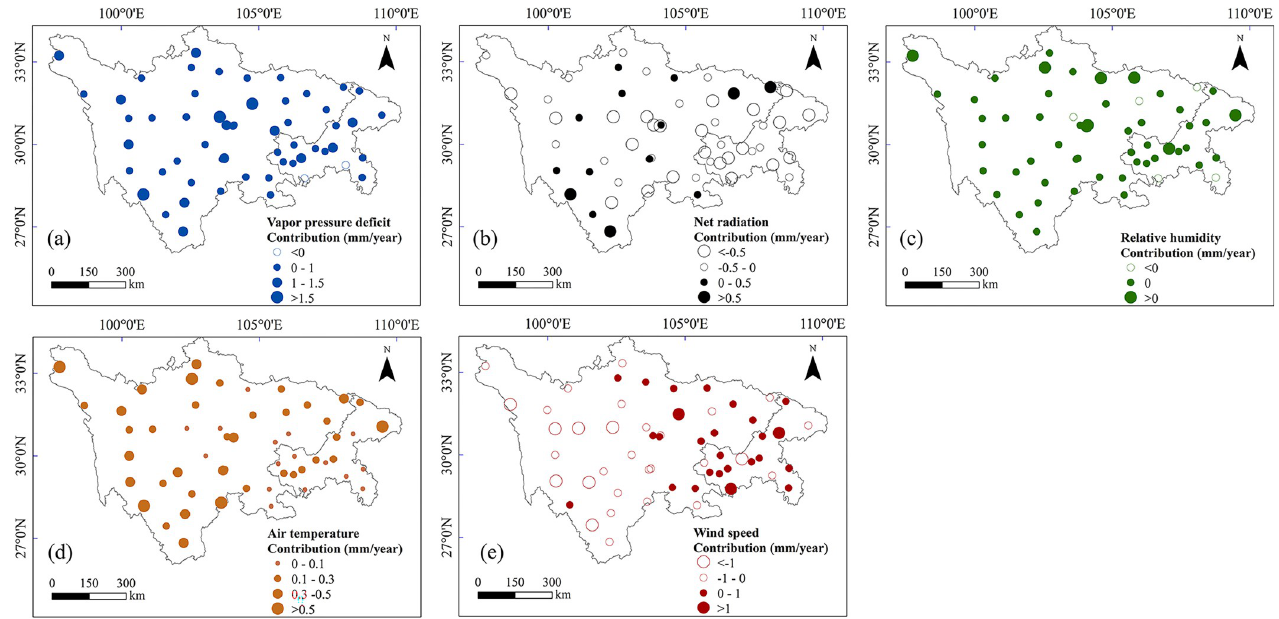
Fig 8. Spatial distributions of contributions of five basic meteorological factors ((a) vapor pressure deficit, (b) net radiation, (c) relative humidity, (d) air temperature, and (e) wind speed) to PET trends at an annual scale.